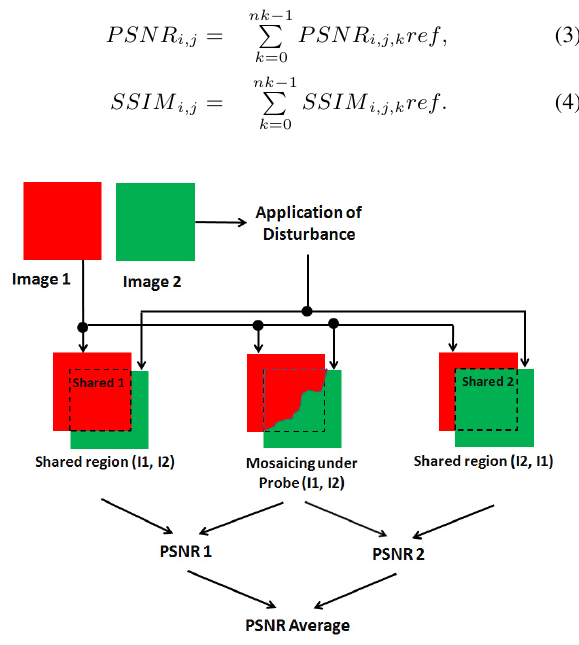
Figure 3. Process for mosaicing assessment